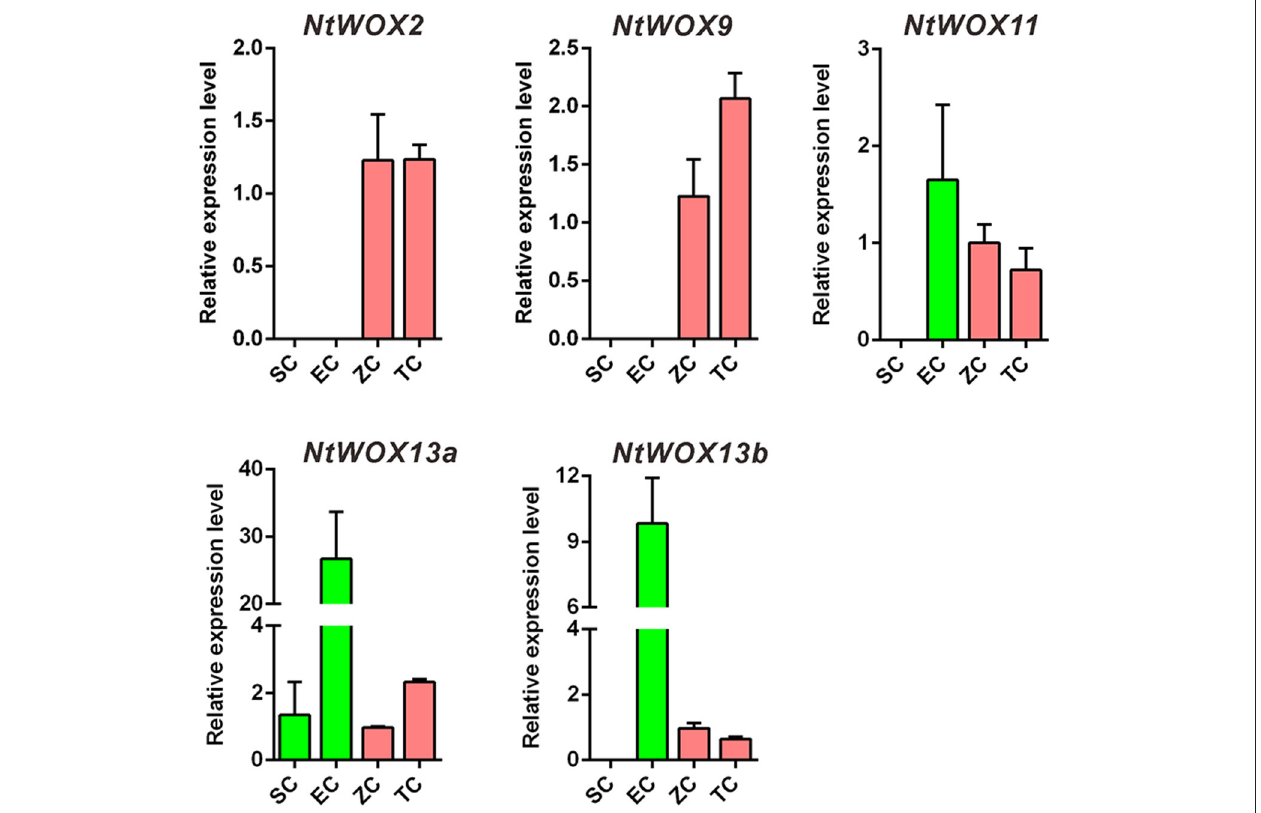
FIGURE 4 | Test of de novo or gamete-delivered transcripts in zygote. Relative expression levels of WOXs in sperm cells (SC), egg cells (EC), zygote (ZC), and 2-celled proembryos (TC). The expression level of each WOX in zygote was set as 1. The expression level was normalized to the average expression level of GAPDH (AJ133422), polyubiquitin (GQ281244), and elongation factor 1 α (AF120093). Error bars represent ± standard error from three independent